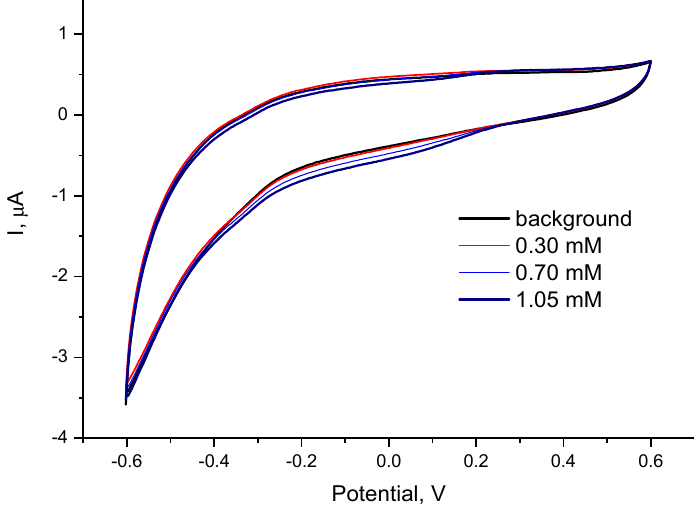
Figure 3. Cyclic voltammograms of GC electrode modified with Nafion™ in the absence and pres- ence of tBHP); background electrolyte: phosphate buffer, pH = 7, reference electrode Ag|AgCl (KCl sat); scan rate 20 mV/s.). scan rate 20